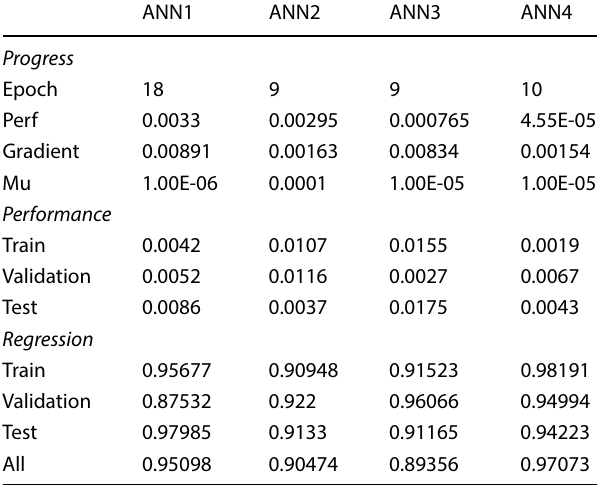
Table 6 The specific characteristics of ANN